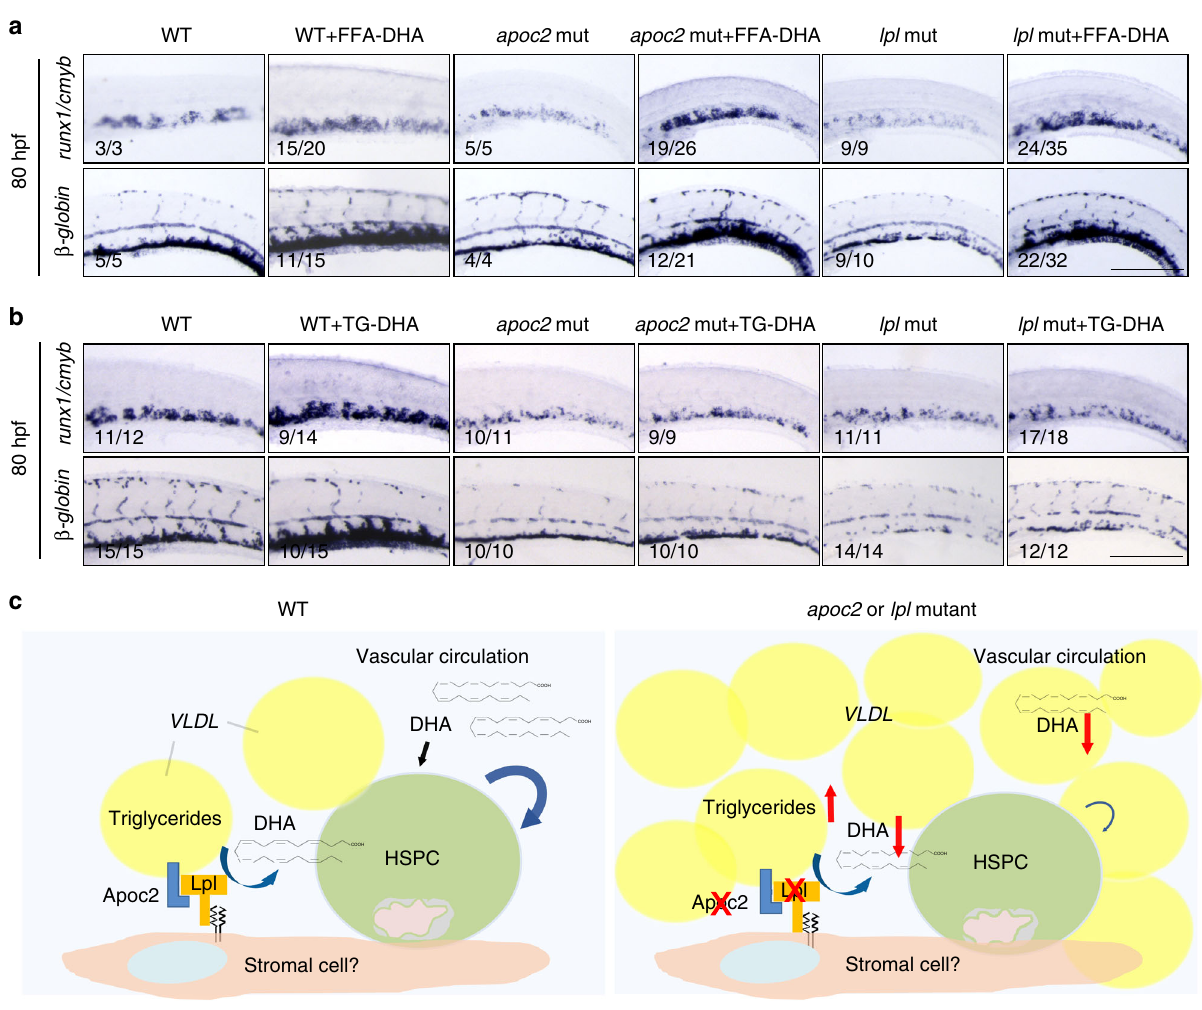
Fig. 8 FFA-DHA but not TG-DHA rescues hematopoiesis in apoc2 and lpl mutants. a , b In situ hybridization with runx1/cmyb and β -globin probes in WT, apoc2 and lpl mutants injected with FFA-DHA ( a ) or TG-DHA ( b ) at 2 dpf; embryos were fi xed at 80 hpf for in situ hybridization. Scale bars, 200 μ m. c Schematic representation of the working hypothesis. VLDL delivers both the TG substrate and Apoc2, an obligatory activator of Lpl to the hematopoietic niche. Lpl, expressed on stromal and/or endothelial cells, catalyzes hydrolysis of TG to produce FFAs. Among FFAs released by the Apoc2/Lpl catalysis, the essential fatty acid DHA supports normal hematopoiesis. apoc2 and lpl mutant zebra fi sh in which TG hydrolysis is blocked, have a defect in HSPC maintenance and differentiation. Administration of DHA as a free fatty acid, but not DHA esteri fi ed into a TG, rescues the hematopoiesis defect in